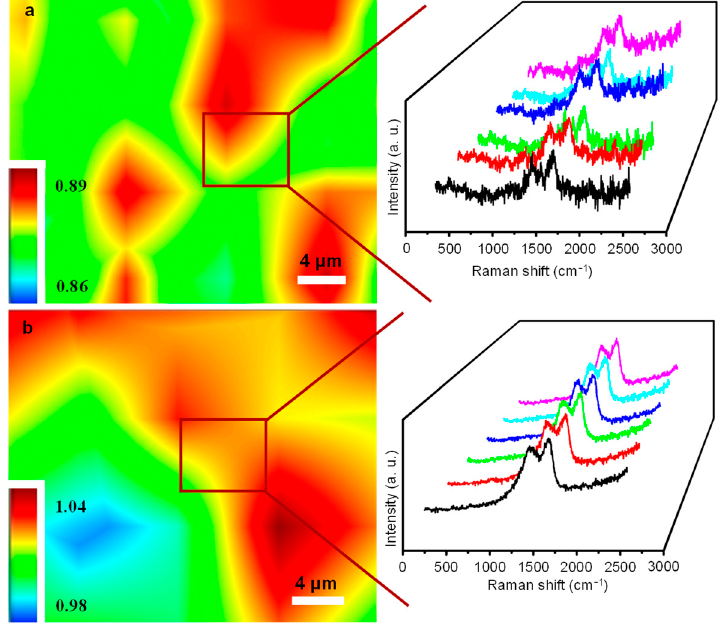
Figure 8. Raman spectra of GQDs ( a ) and N − GQDs ( b ) (Raman plane scan image on the left).